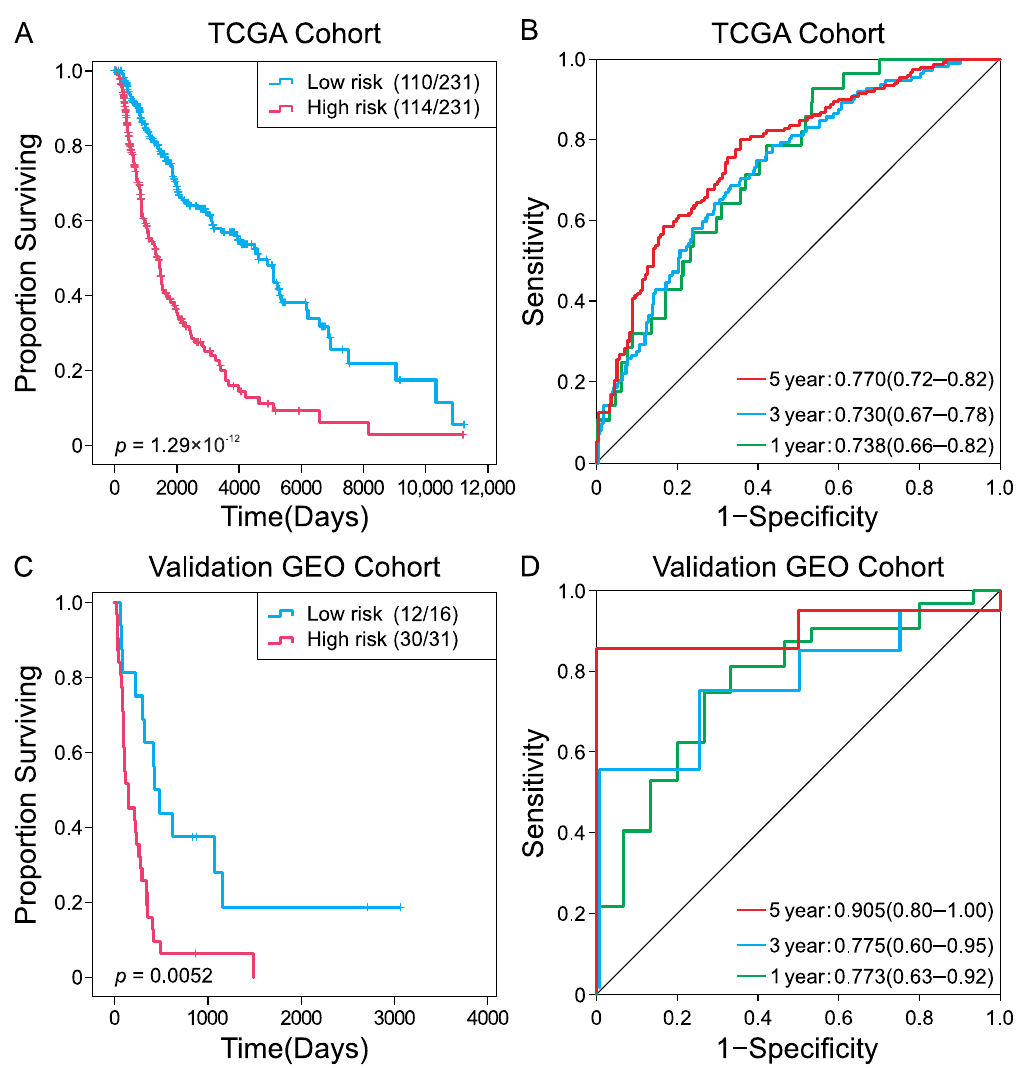
Figure 3. Kaplan–Meier survival and ROC analyses of the four-FRG DNA methylation prognostic signature in the discovery TCGA cohort ( A , B ) and the validation GEO cohort ( C , D ). Kaplan–Meier analysis combined with Wilcoxon test was used to visualize and compare the OS in low- and high- risk groups. AUC values for the 1, 3, and 5-year survival to show the prognostic performance of the